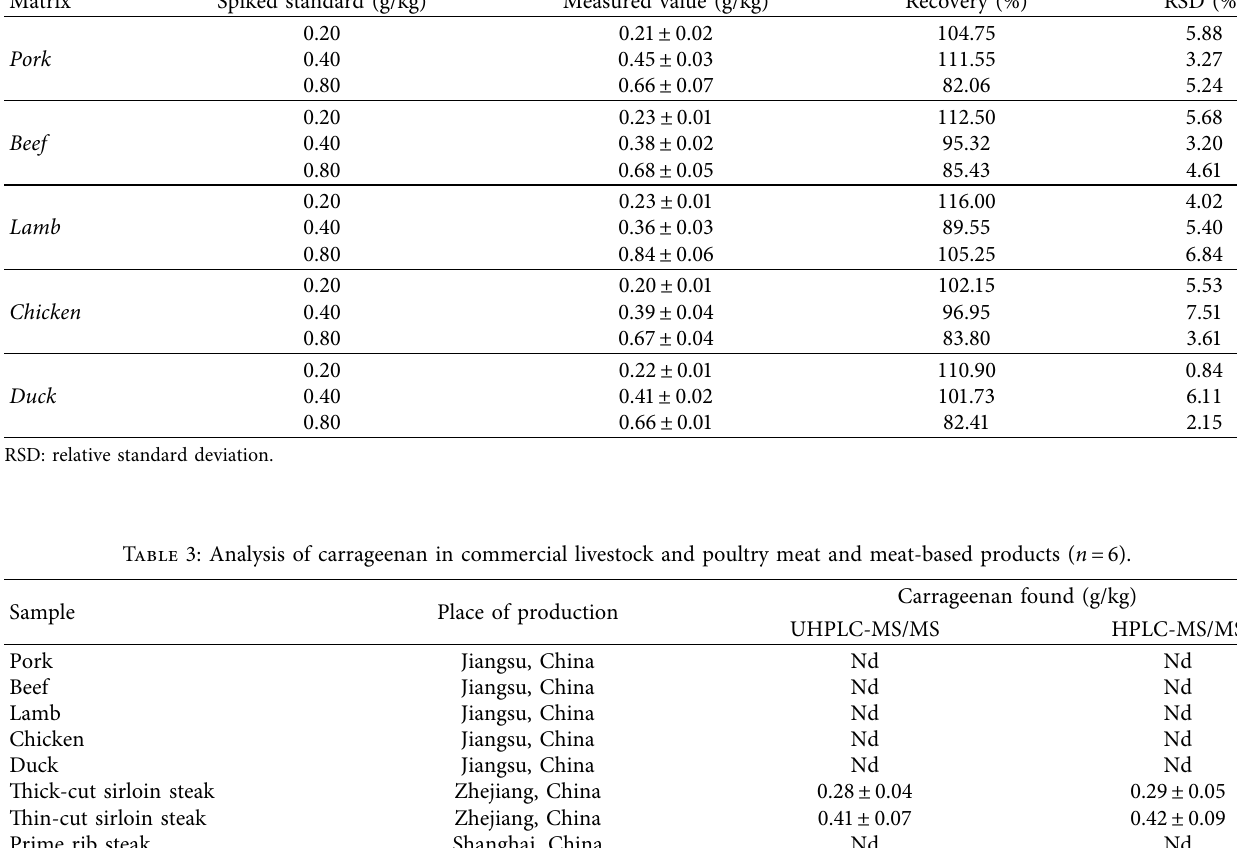
Table 2: The recovery and precision of spiked carrageenan standard in livestock and poultry meat ( n � 6). Matrix